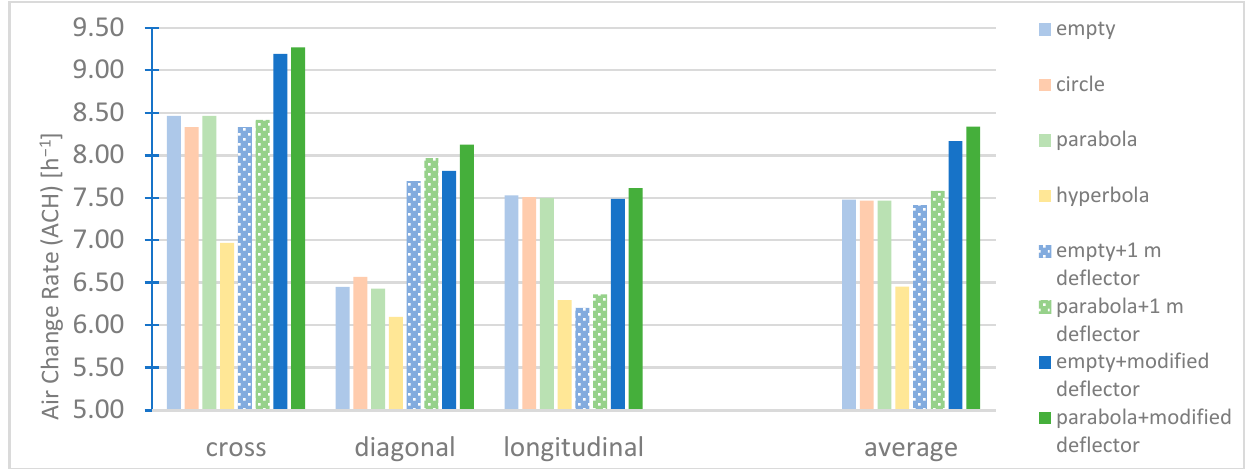
Figure 17. Comparison of geometry variations’ performance in ACH [h − 1 ] with the modified deflectors of the ‘empty’ and ‘parabola’ versions.